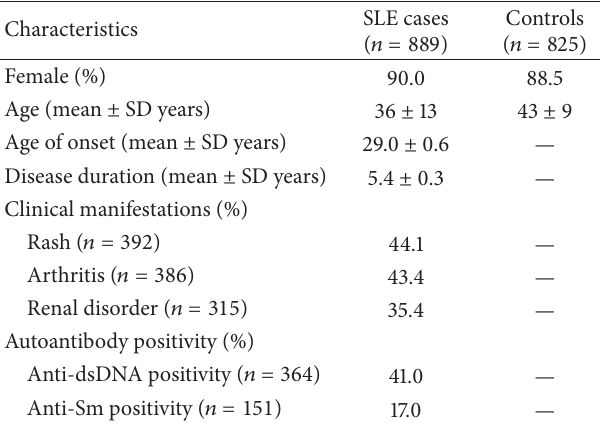
Table 1: Demographic and clinical characteristics of subjects.